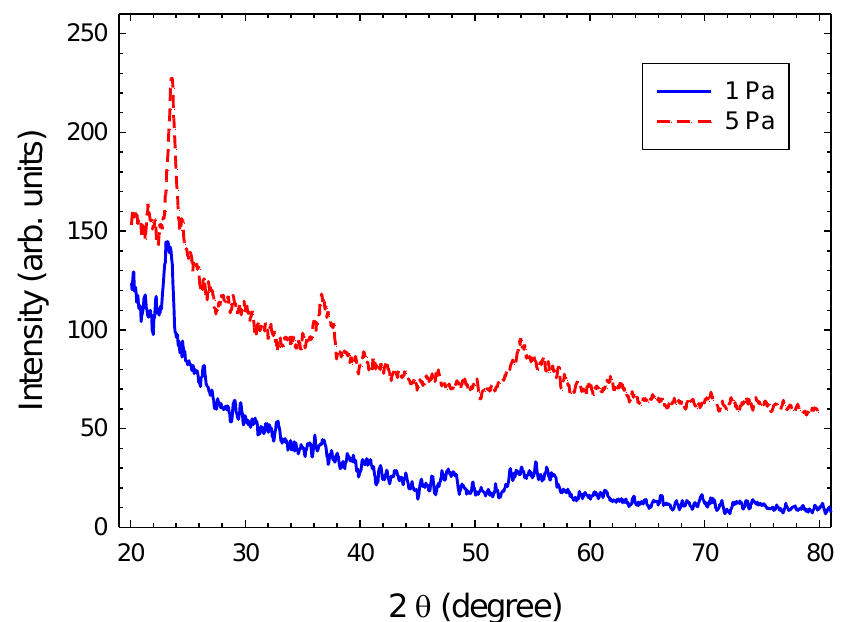
Figure 9. GIXD pattern of Ti x -Cu y N z films deposited at 1 Pa and 5